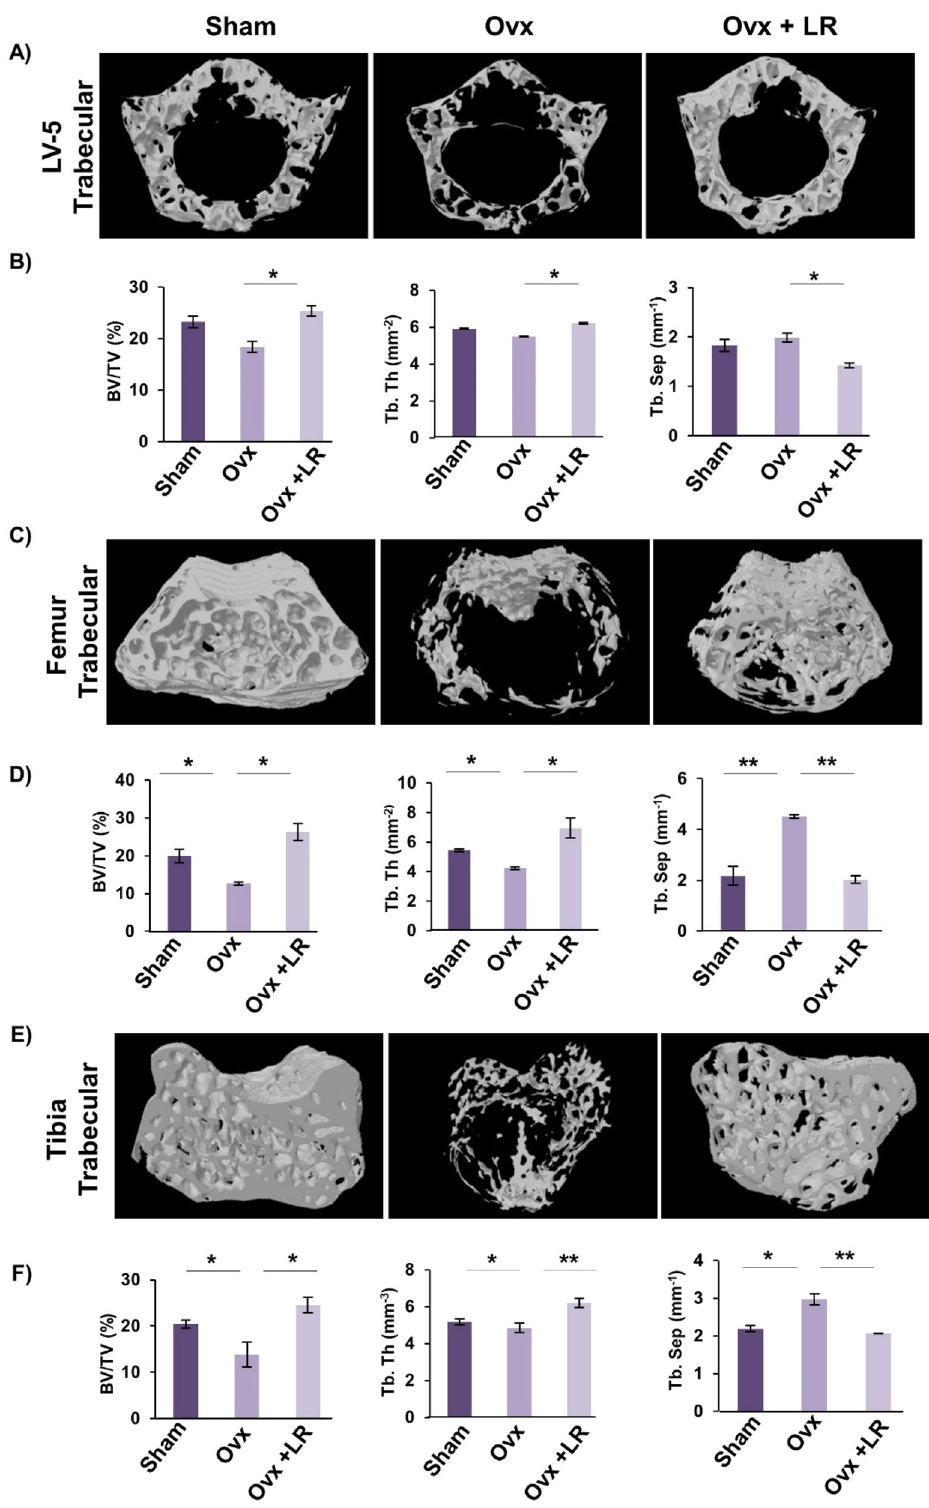
Figure 5. LR administration enhances trabecular bone microarchitecture. 3-D µCT reconstruction of LV-5 Trabecular, Femur Trabecular and Tibia Trabecular of all groups. ( A ) Bone micro-architecture of LV-5. ( B ) Histomorphometric parameters of LV-5. ( C ) Bone micro-architecture of femur trabecular. ( D ) Histomorphometric parameters of femur trabecular. ( E ) Bone micro-architecture of Tibia trabecular. ( F ) Histomorphometric parameters of Tibia trabecular. Bone volume/tissue volume ratio (BV/TV); Tb. Th., trabecular thickness; Tb. Sp., trabecular separation. The results were evaluated by ANOVA with subsequent comparisons by Student t-test for paired or nonpaired data. Values are reported as mean ± SEM. The above graphical representations are indicative of one independent experiment and similar results were obtained in two different independent experiments with n = 6. Statistical significance was considered as p ≤ 0.05 (* p ≤ 0.05, ** p ≤ 0.01, *** p ≤ 0.001) with respect to indicated mice